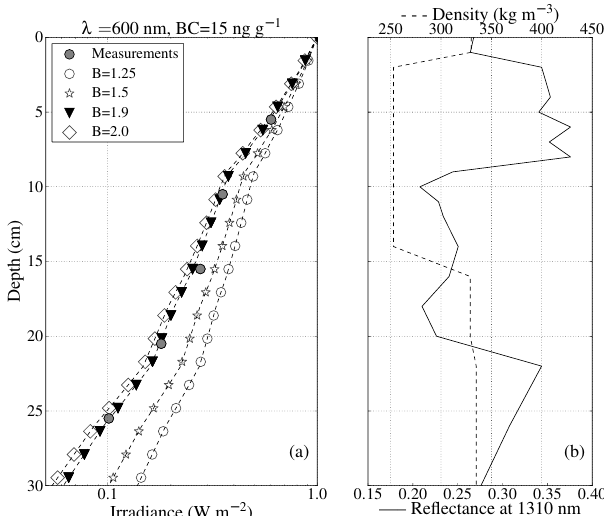
0.1 Fig. 2. Measurements conducted at Col de Porte (29 February = 600nm is 2012). (a) The measured irradiance profile at λ 1 k e shown with the optimal modelled profile symbolized by dark in- verted triangles. The other profiles have been calculated for various values of B and incident flux equal to the optimal I 0 ( 600nm ) . All profiles are normalized at the surface. (b) Vertical profiles of density and reflectance at 1310nm used to compute the irradiance profiles in (a)